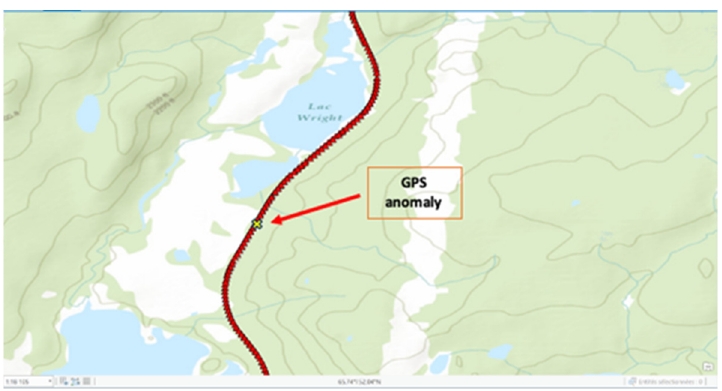
Figure 6. GPS coordinates mapping between Sept-Îles and Schefferville (isolated environment).